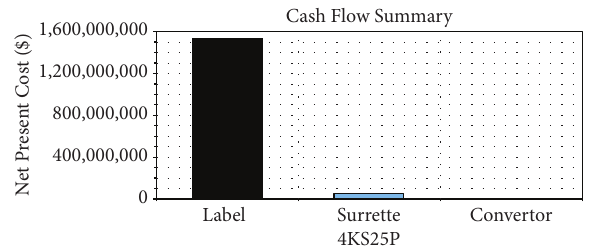
Figure 6: The result of 1MW landfill simulation by